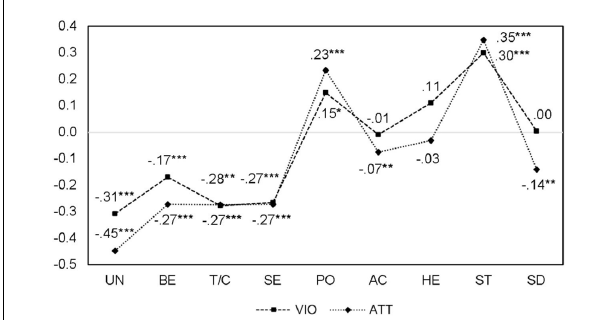
albeit small effects on attitudes toward violence ( p < 0.05)